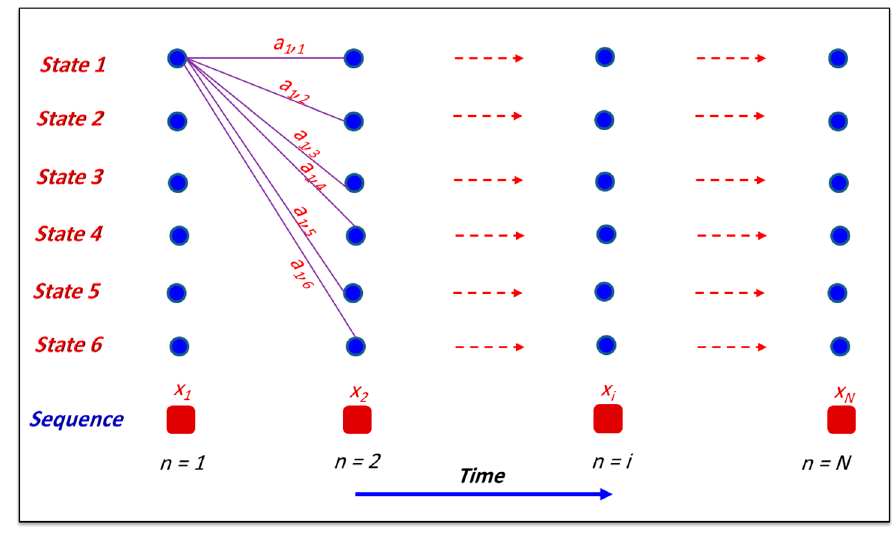
Figure 3. Trellis diagram showing the general architecture of six hidden Markov model (HMM) states.